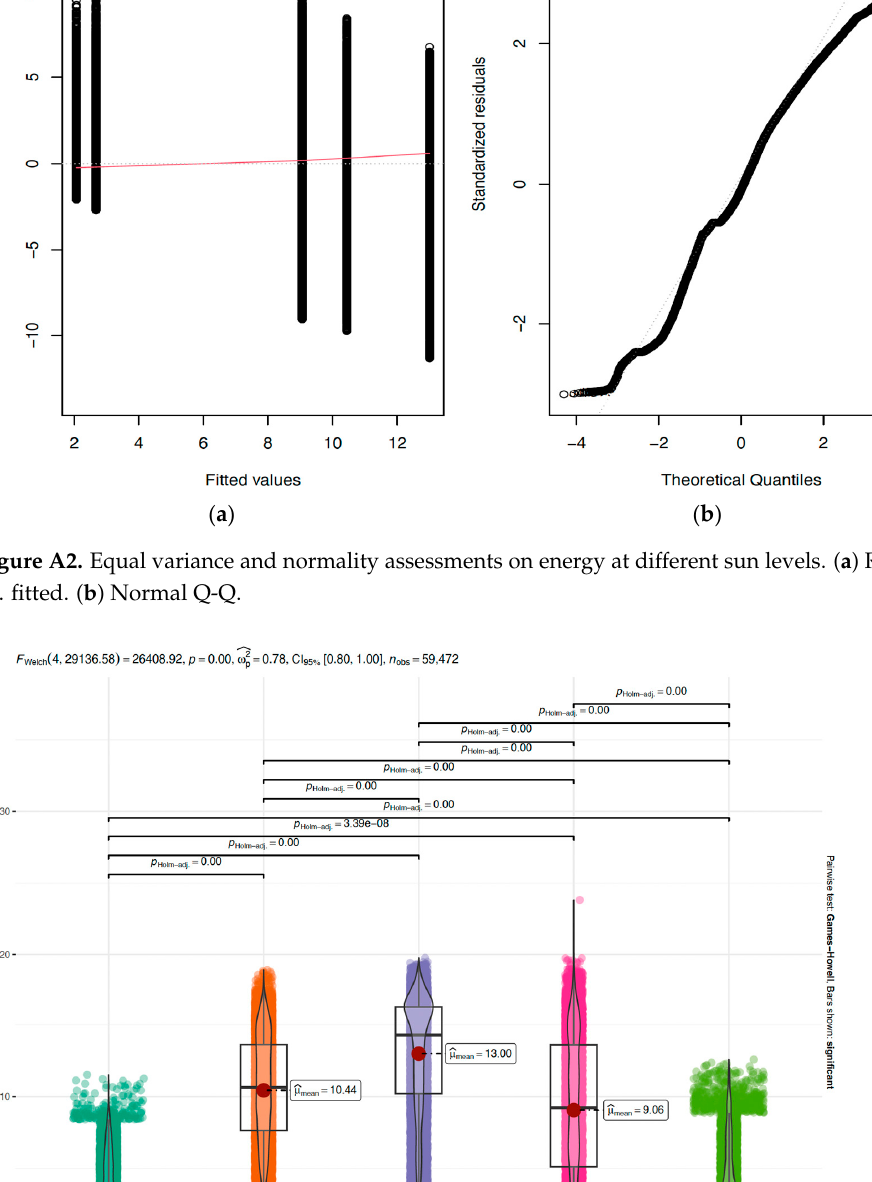
Figure A3. Welch ANOVA on energy at di ff erent sun levels. Table A2. Pairwise comparison in energy at di ff erent sun levels using Games-Howell test. Contrast Pair Estimate Confidence Interval p ‐ Value Adjusted